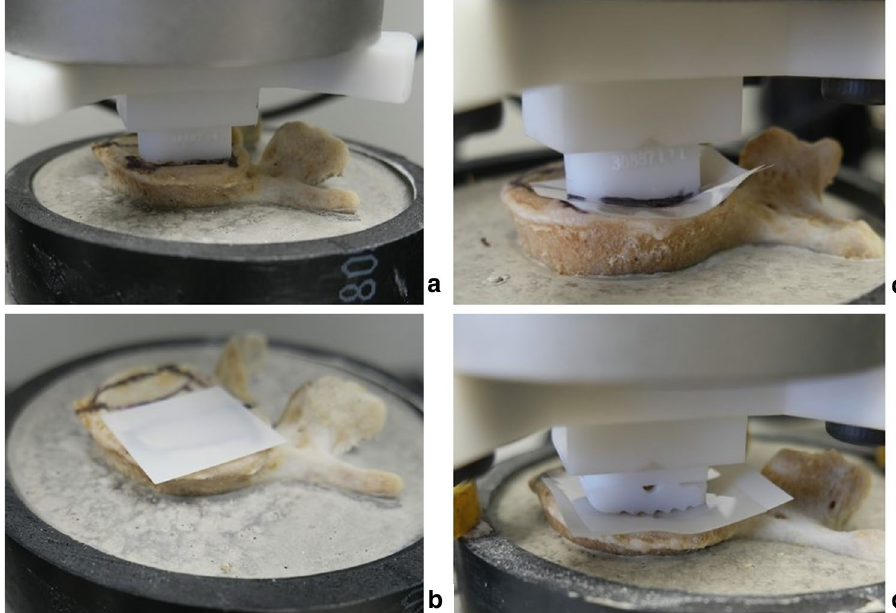
Figure 6. ( a ) Ideal cage position was determined using PS cage, ( b ) FujiFilm was put in place, ( c,d ) PS and commercial cage being compressed over the